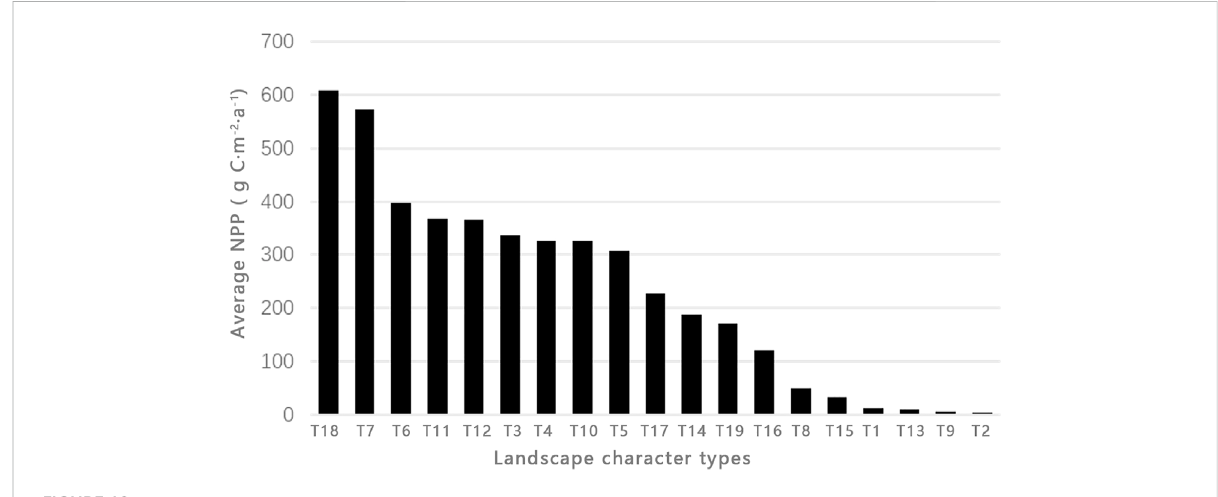
FIGURE 10 Promotion potential of NPP from different types of landscape